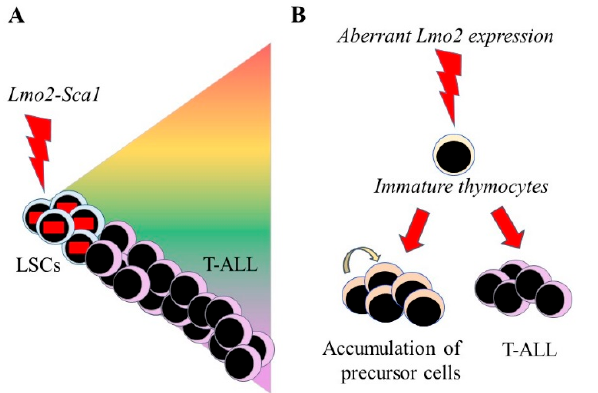
Figure 2. The influence of Lmo2 expression on hematopoietic stem and progenitor cells ( A ) In transgenic mice, the expression of Lmo2 is restricted to hematopoietic stem and progenitor cells, via the Sca-1 promotor, leading to T-cell acute lymphoblastic leukemia (T-ALL). The oncogene is active solely within the leukemia stem cells (LSCs) and therefore not essential for the survival/proliferation of the more mature lineage-affiliated leukaemia cells. ( B ) Aberrant expression in immature thymocytes leading to an accumulation of precursor cells and T-ALL.